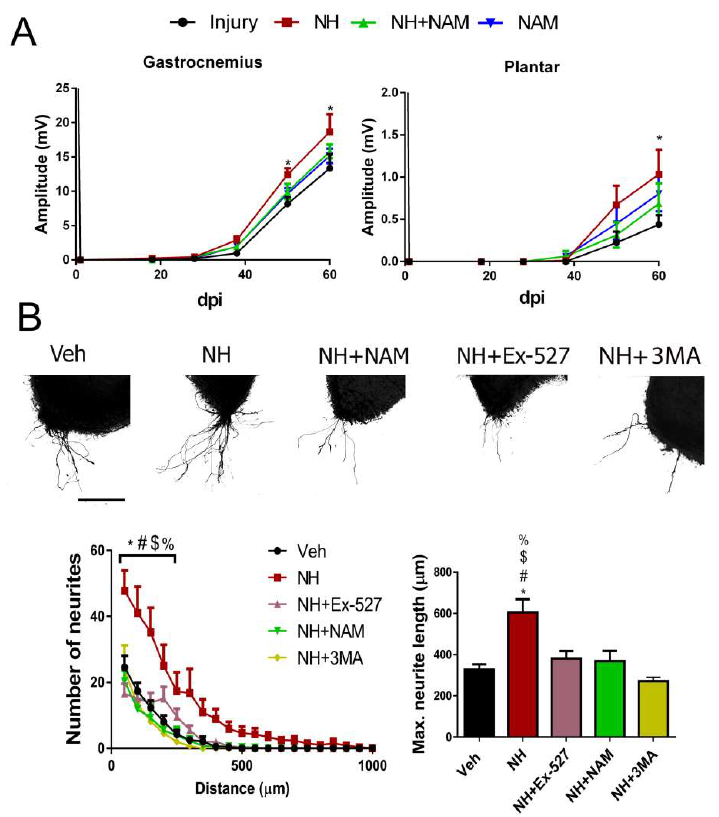
Figure 2. Pro-regenerative e ff ect of NeuroHeal requires SIRT1 activity and autophagy. ( A ) Mean amplitudes ( ± SEM) values of CMAP recordings obtained during follow-up post-axotomy from gastrocnemius (GA) and plantar muscles in animals treated with NH, NH + nicotinamide (NAM), or NAM (n = 5–6, ANOVA, post hoc Bonferroni, * p < 0.05 vs. Injury). ( B ) Representative microphotographs of Veh-, NH-, NH + Ex-527-, NH + NAM-, and NH + 3MA-treated spinal cord organotypic cultures (SOCs) embedded in collagen. Graphs show the number of neurites per intersection and the maximum neurite length in the SOC (n = 8–10, ANOVA, post hoc Bonferroni, * p < 0.05 vs. Veh, # p < 0.05 vs. NH + Ex-527, $ p < 0.05 vs. NH + NAM, % p < 0.05 vs. NH + 3MA). Scale bar = 250 μm .